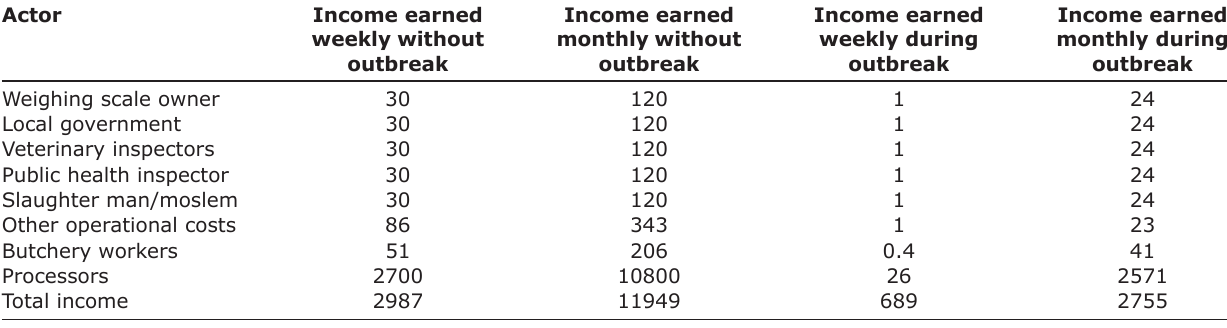
Table-15: Total income earned (US dollars) by processing actors per head of cattle during outbreaks and non-outbreak periods in Nakasongola district.